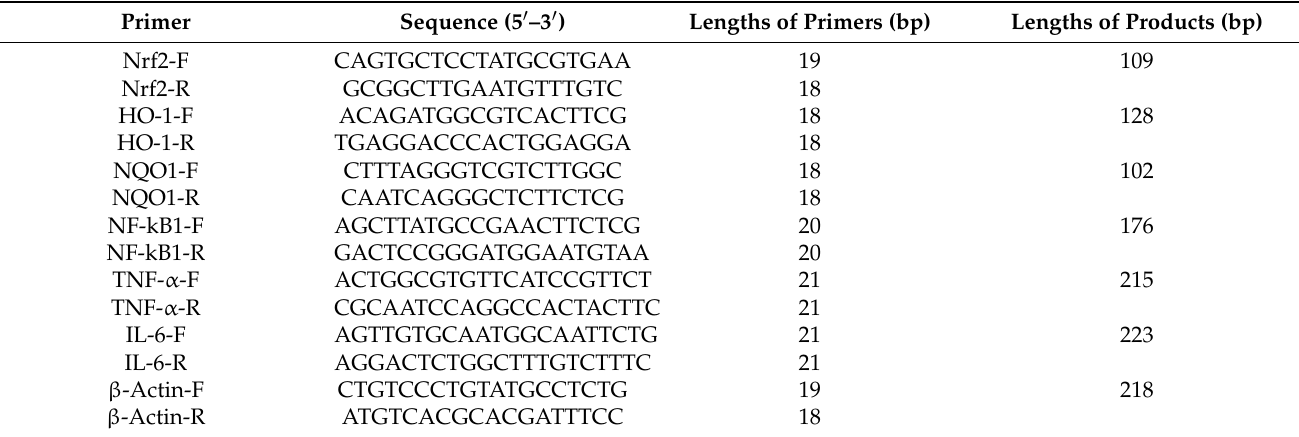
Table 4. Sequences of primers in